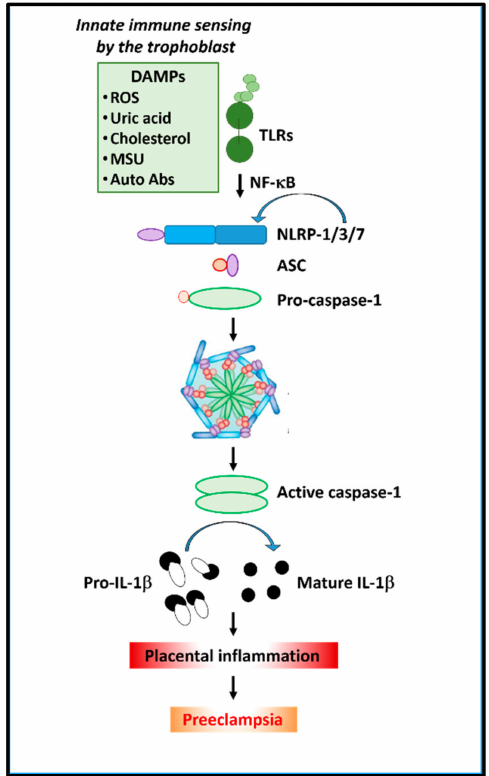
Figure 3. Depicts the role of inflammasomes in placental inflammation in preeclampsia. Cholesterol or uric acid crystals (alarmins) and extracellular vesicles / microparticles can trigger NLRP (1 / 3 / 7) inflammasomes in the placenta, which releases active caspase-1 and mature IL-1 β and increases